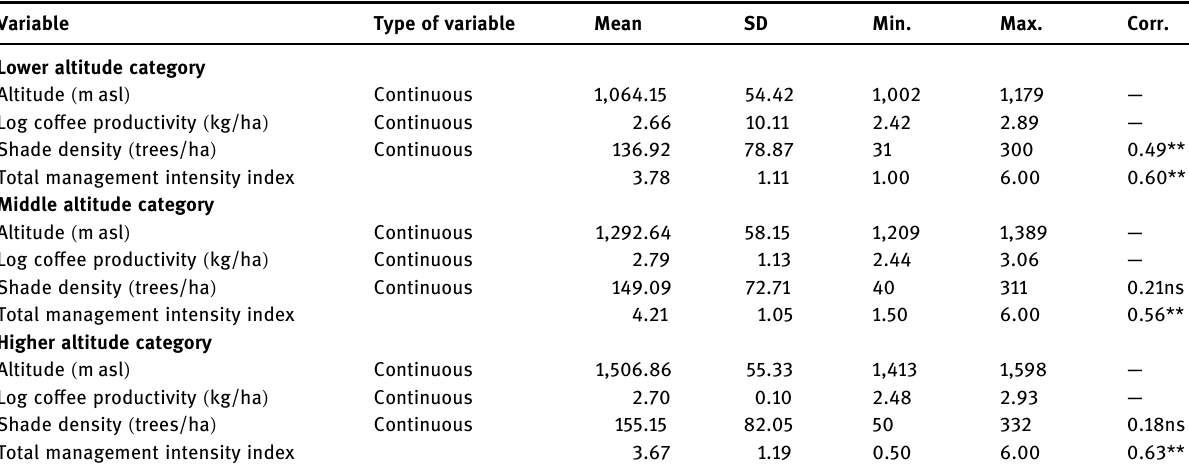
Table 3: Co ff ee plot characteristics in lower altitudes (> 1,000 – 1,200 m asl, n = 78 ) , middle altitudes (> 1,200 – 1,400 m asl, n = 84 ) , and higher altitudes (> 1,400 – 1,600 m asl, n = 72